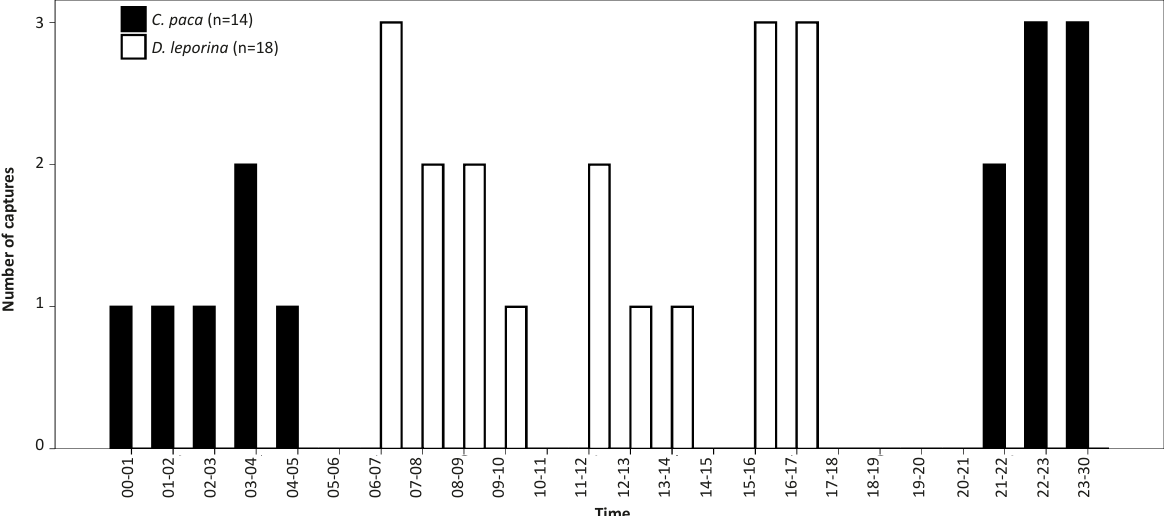
Figure 2. Activity patterns of Spotted Pacas (dark bars) and Red-rumped Agoutis (white bars) in GNP. Spotted Pacas were nocturnal and Red-rumped Agoutis were diurnal (based on Van Schaik y Griffiths 1996), without overlap in their